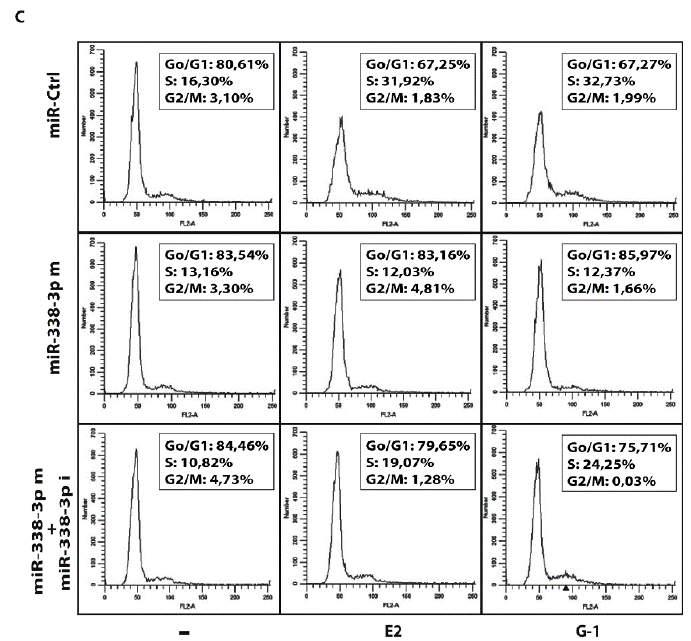
Figure 9. miR-338-3p decreases the proliferation of SkBr3 cancer cells and CAFs induced by E2 and G-1. Cell proliferation in SkBr3 cancer cells ( A ) and CAFs ( B ) transfected every 2 days with 100ng shRNA or shGPER, 100ng vector or a dominant-negative c-Fos construct (DN-Fos) and 25 nM miR-Ctrl or miR-338-3p mimic (miR-338-3p m) in combination or not with 50 nM miR-338-3p inhibitor (miR-338-3p i). Cells were treated every day with 100 nM E2 or 100 nM G-1 and counted on day 6. Each column represents the mean ± SD of three independent experiments performed in triplicate. (*) indicates p < 0.05 for cells receiving treatments vs cells treated with vehicle (-). ( C ) Representative pictures of cell cycle analysis in CAFs transfected for 48 h with 25 nM miR-Ctrl or miR-338-3p mimic (miR-338-3p m) in combination or not with 50 nM miR-338-3p inhibitor (miR-338-3p i) before the treatment for 24 h with 100 nM E2 and 100 nM G-1. In each panel, the percentages of cells in G0/G1, S and G2/M phases of the cell cycle are indicated. Values represent the mean ± SD of three independent